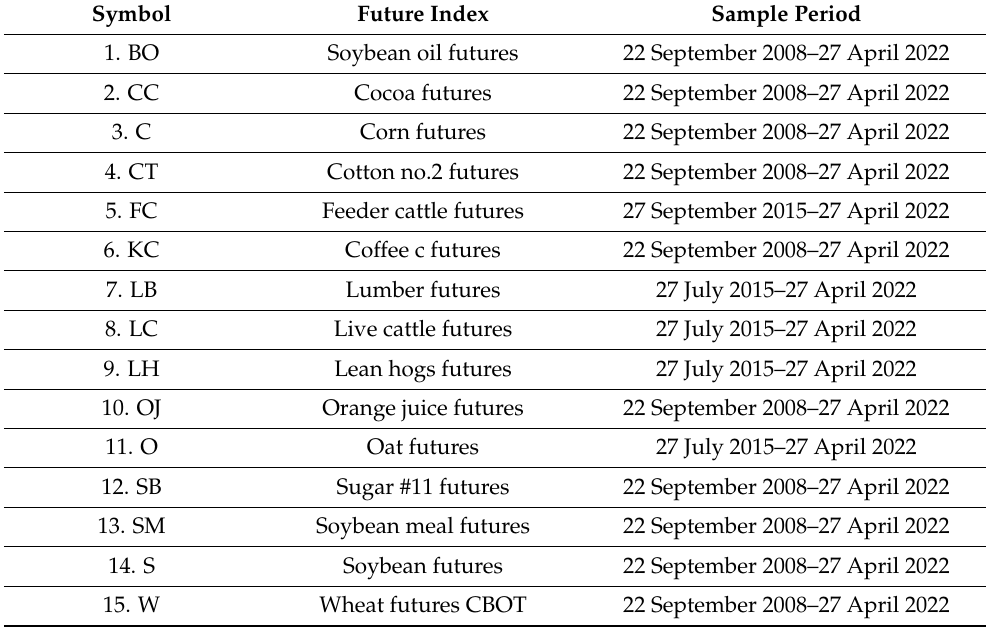
Table A1. Selected variables, acronyms, and sample